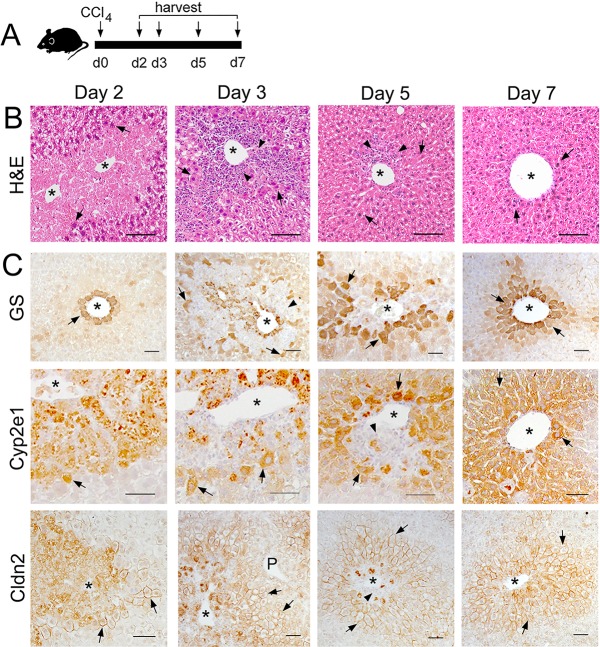
Changes in liver histology and Zone 2/3 protein expression after a CCl4 bolus.(A) Schematic of CCl4 administration and tissue harvesting. (B) H and E staining reveals broad areas of necrosis separating the central vein (asterisks) from the hepatocyte area at day 2, abundant perivenous immune infiltrates at day 3, reduced immune infiltrates and partially restored parenchyma at day 5, and normal liver architecture at day 7, following acute CCl4 administration. (Arrow show hepatocytes, arrowheads indicate immune infiltrates). (C) Immunohistochemistry analysis reveals very low GS expression (arrows) remaining around the central veins at day 2, a few GS+ nucleated cells separated from the central vein by a cellular infiltrate (arrowheads) at day 3, increased GS+ cells in perivenous areas at day 5, and normal GS expression in Zone 3 at day seven post-CCl4. Expression of Cyp2e1 and claudin-2 proteins is limited to few hepatocytes located at the margins of the perivenous immune infiltrate at days 2–3. The Cyp2e1+ and claudin-2+ cell population continues to expand pericentrally (day 5) and looks restored 7 days post- CCl4 administration. Each image represents 2–3 individual livers. Scale bars: 50 μm (B, C), 100 μm (A).